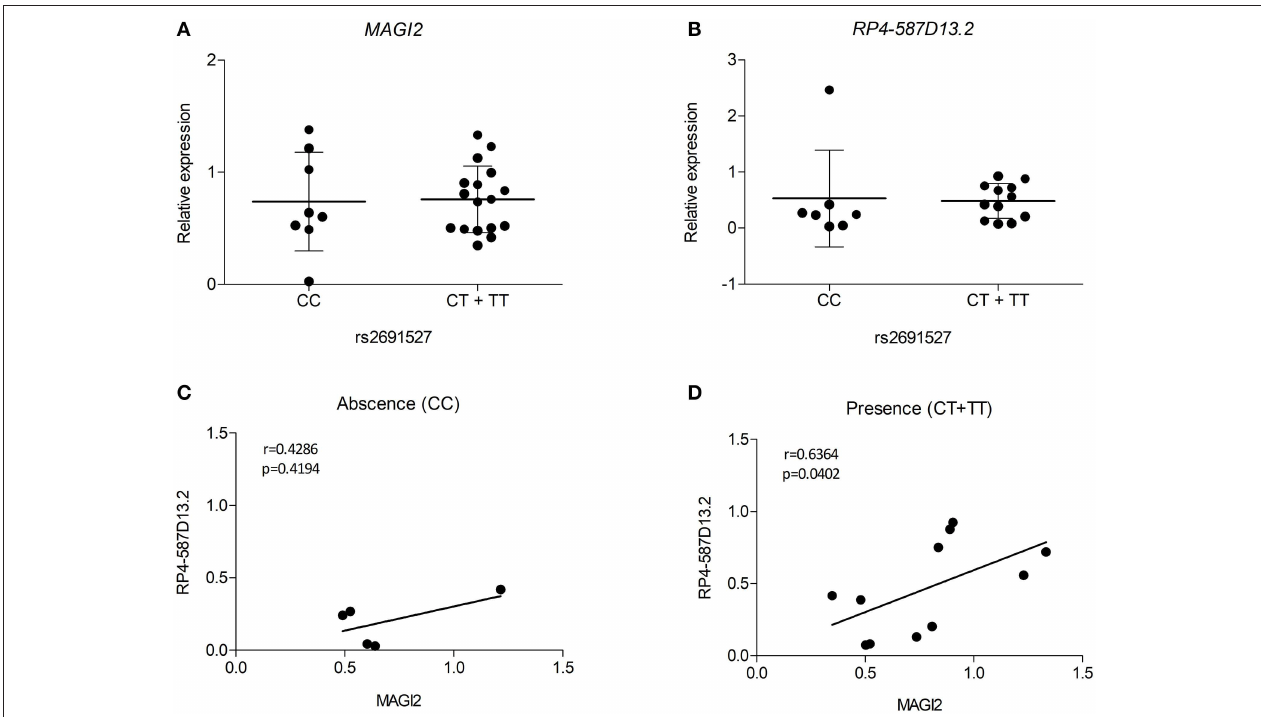
FIGURE 5 | eQTL analyses for (A) MAGI2 and (B) RP4-587D13.2 in duodenal biopsies from patients with CD and non-CD controls. Scatter plots show expression relative to the control mean in patients lacking or harboring the tag SNP rs2691527*T allele. Spearman correlation between MAGI2 and RP4-587D13.2 expression levels according to the (C) absence or (D) presence of tag SNP rs2691527*T